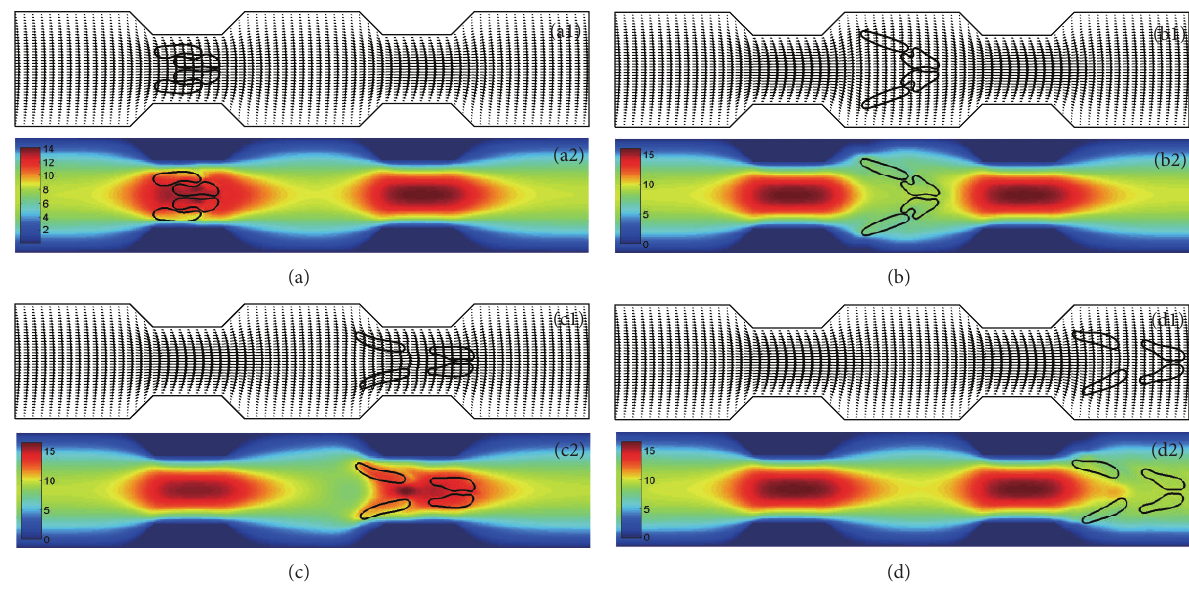
Figure 3: Motion and dissociation of a four-cell erythrocyte aggregate in a 12 𝜇 m stenotic channel at time instants (a) 𝑡 = 0.33 ms; (b) 𝑡 = 0.54 ms; (c) 𝑡 = 0.74 ms; and (d) 𝑡 = 0.92 ms. Velocity vectors (a1-d1) and axial velocity magnitude contours (cm/s) (a2-d2) are presented. The initial configuration for the aggregate is shown in Figure 1(c), and the aggregate is horizontally placed in the channel initially. The parameters used are 𝐷 𝑒 = 1.0 × 10 −2 𝜇 J/m 2 , 𝑘 𝑏 = 5.0 × 10 −13